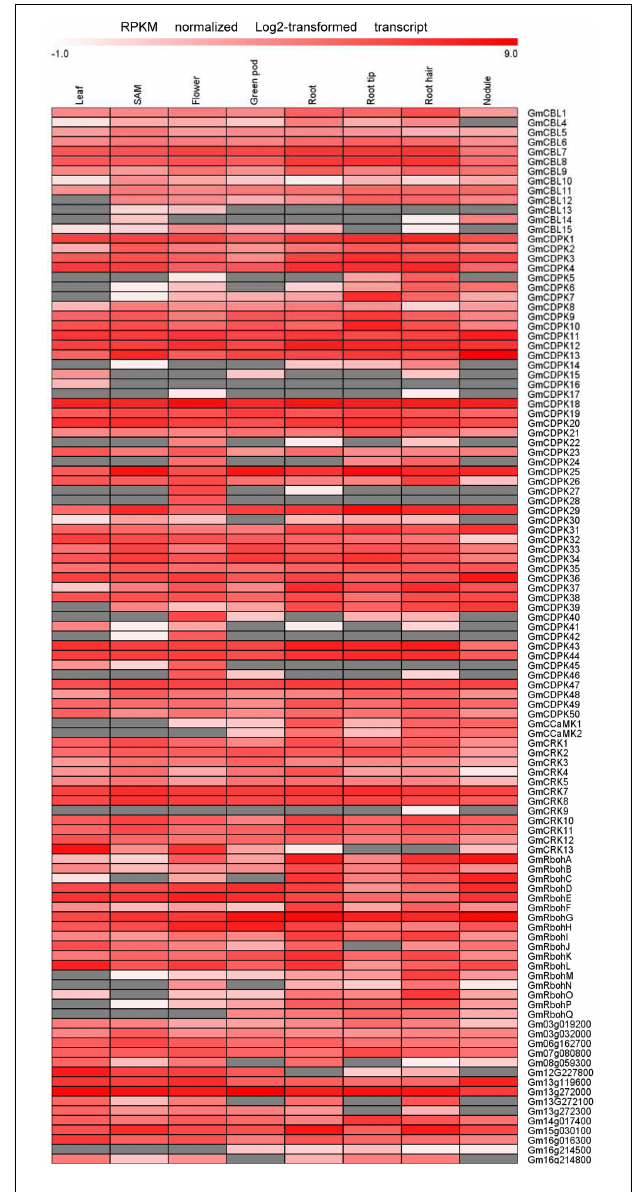
FIGURE 10 | Heat map representation for tissue-specific expression patterns of predicted EF-hand protein-coding genes with the exception of GmCaM/CML s according to Illumina transcriptome data. The RPKM normalized log2 transformed counts were visualized in the heat map. The red colors indicate expression intensity, gray color indicates no expression detected. (Day et al., 2002; Boonburapong and Buaboocha, 2007).